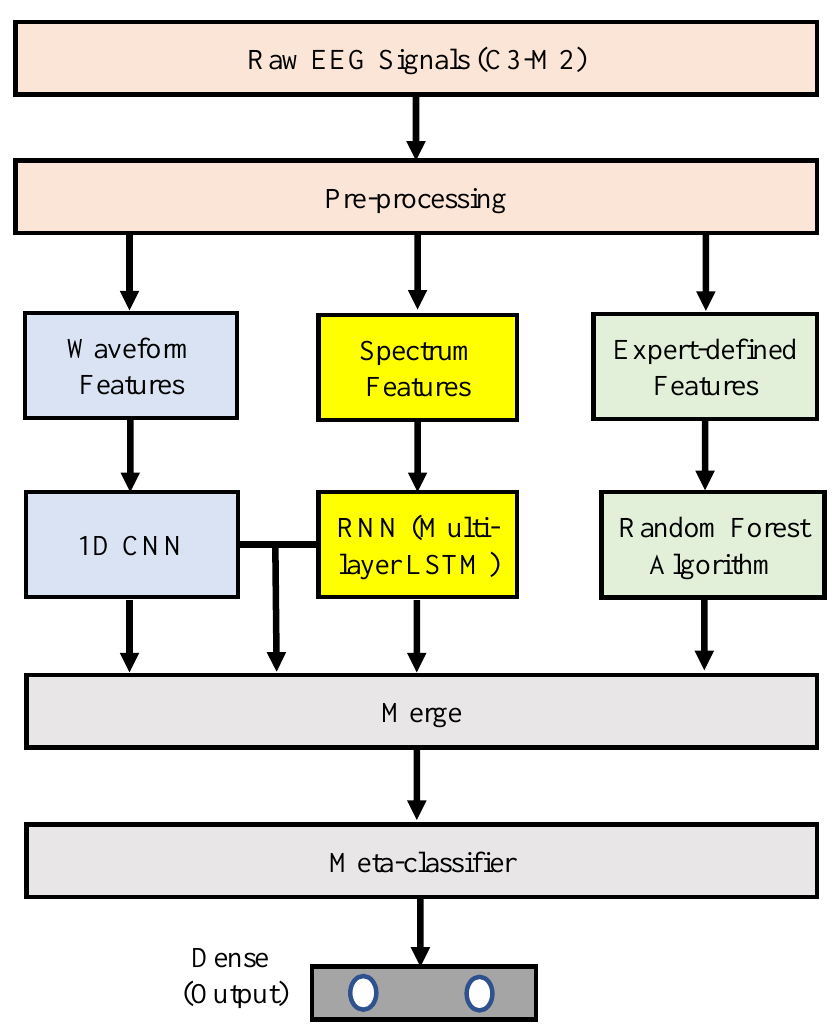
Figure 1. Block diagram of the proposed stacking ensemble learning approach for sleep-arousal